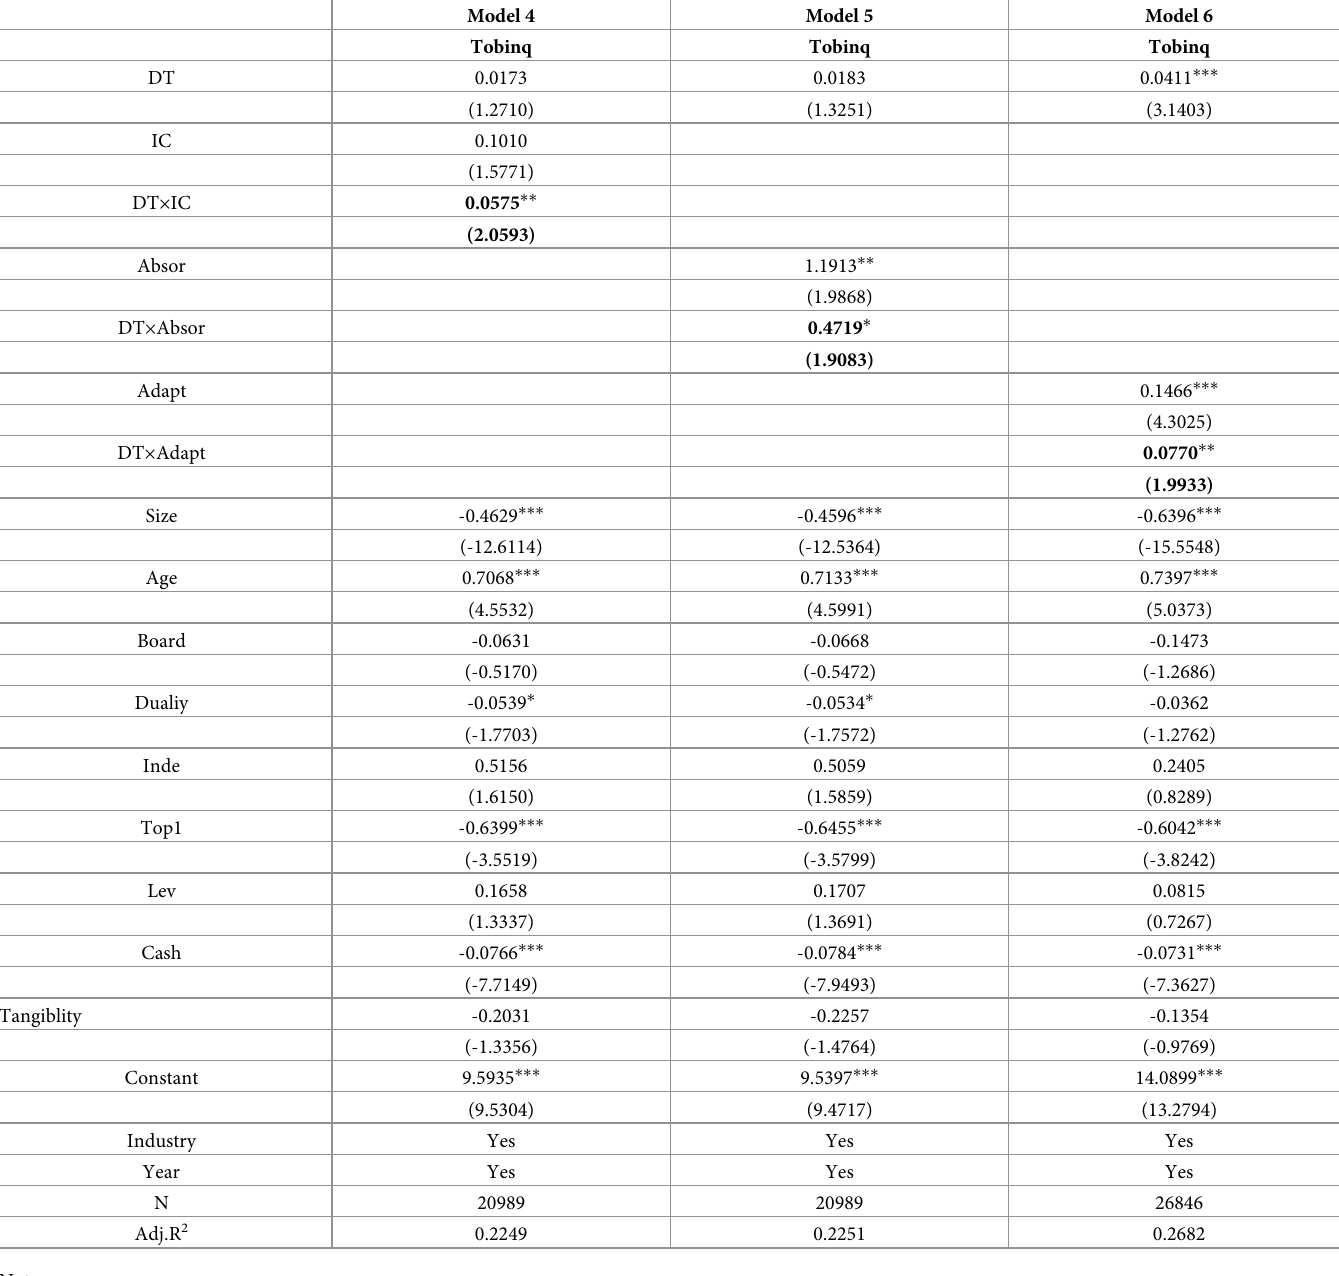
Table 10. The moderating effect of dynamic